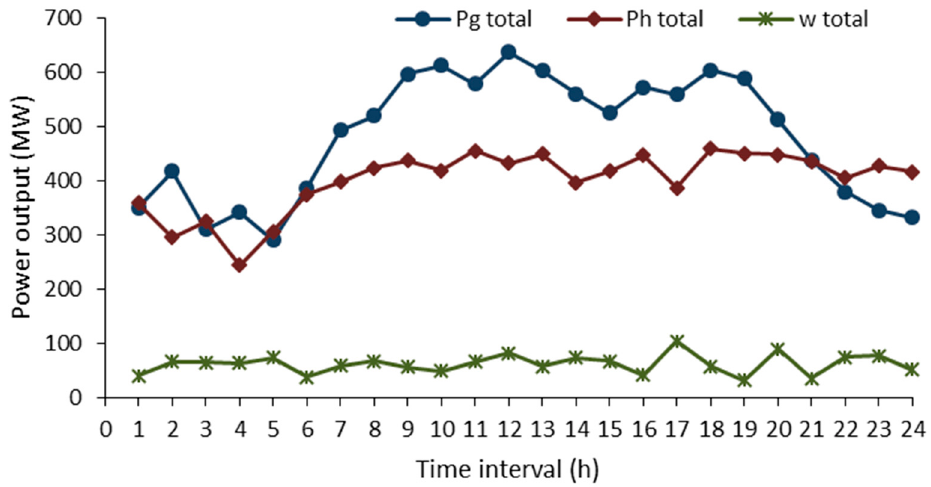
Figure 4. Optimal power generation schedules from the MPSO algorithm over 24 h time span .